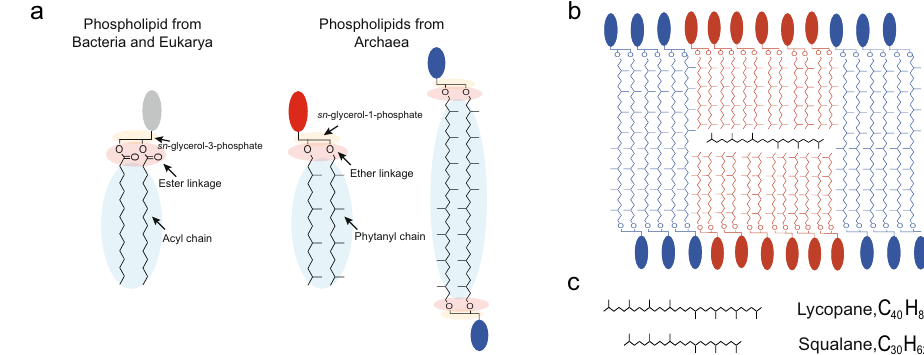
Fig. 1 The lipid divide and membrane organization in Thermococcus barophilus . a Skeletal representation of phospholipids from Bacteria and Eukarya (left) and from Archaea (right). The arrows indicate the main differences between them. b The proposed membrane ultrastructure for the polyextremophilic archaeon Thermococcus barophilus . The membrane is composed of ca. half of monolayer-forming tetraether phospholipids (in blue with a blue polar headgroup) and half of bilayer-forming diether phospholipids (in red with a red polar headgroup). It is organized in membrane domains in monolayer or bilayer. The midplane of the bilayer is populated by c ) polyunsaturated polyisoprenoids of 30 (squalane-derivatives, minor fraction) to 40 carbons (lycopane-derivatives, major fraction, black